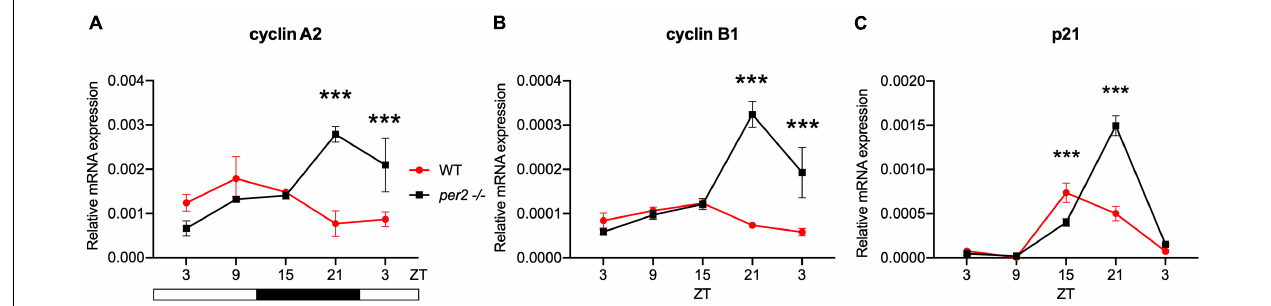
FIGURE 9 | Per2 knockout alters the rhythmic mRNA expression of cell cycle regulator genes in adult zebrafish fin tissues. qRT-PCR analysis of expression levels of some cell cycle CCGs (A) cyclin A2, (B) cyclin B1, and (C) p21 in WT and per2 KO fin tissue. Sets of 4 WT and per2 KO fishes (each set containing two males and two females) were maintained under LD cycle (14 h light-10 h dark) conditions, a portion of caudal fin tissue was amputated and pooled for RNA extraction at 6-h intervals during a sampling window of 24 h. Mean mRNA relative expression ( n = 2–3) ± SD is plotted on the y -axis; zeitgeber time (ZT) is plotted on the x -axis. Zeitgeber times are indicated for each sample. ZT0 corresponds to lights-on, ZT14 to lights-off. A change in rhythm was observed for cyclin A2 , cyclin B1 , and p21 , as determined by a significant ANOVA Genotype × Time interaction effect for all genes ( p < 0.001, see Table 1 ). Asterisks represent levels of significance in comparing the two genotypes at each time point individually, corrected by Sidak’s method (*** p <